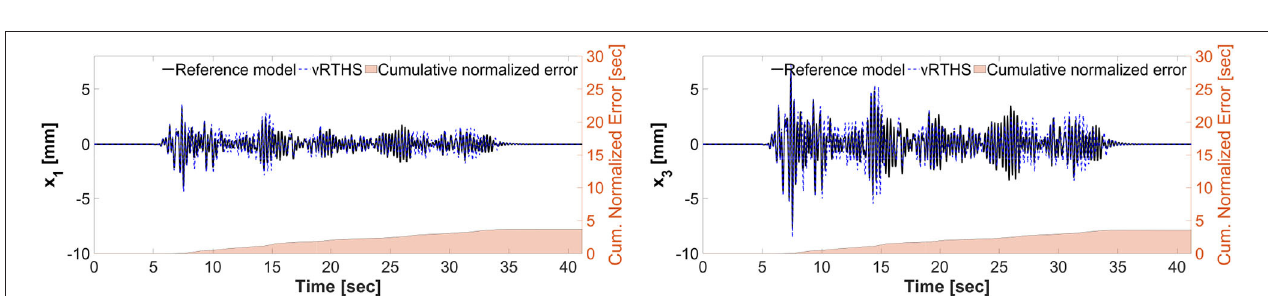
FIGURE 13 | Study 2 (Case 1): virtual-RTHS response comparisons of the 1st and 3rd floor displacements under El Centro excitation.